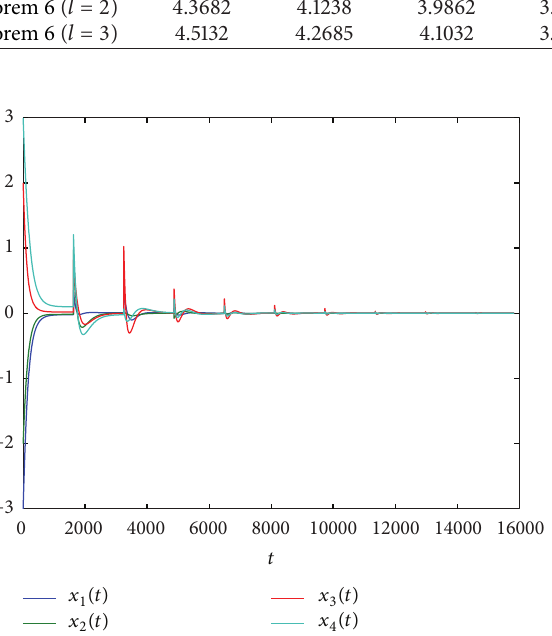
Figure 1: The simulation of Example 1 for ℎ = 𝑟 = 4.8652 , where the initial value is [−3, −2,2, 3] 𝑇 , ℎ 𝐷 = 0 , 𝑙 = 3